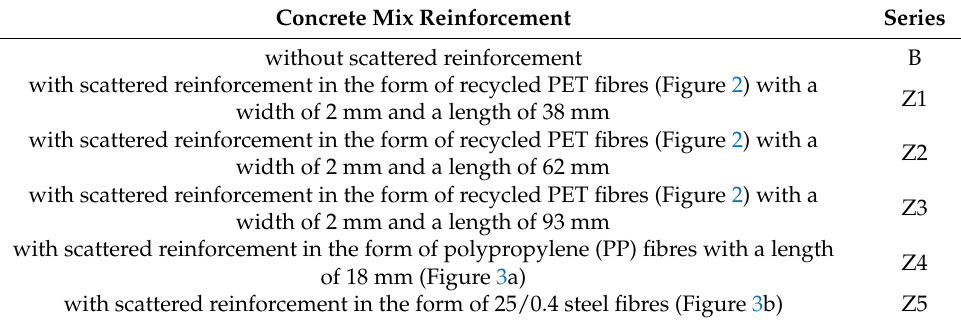
Table 2. Concrete mix reinforcement for each